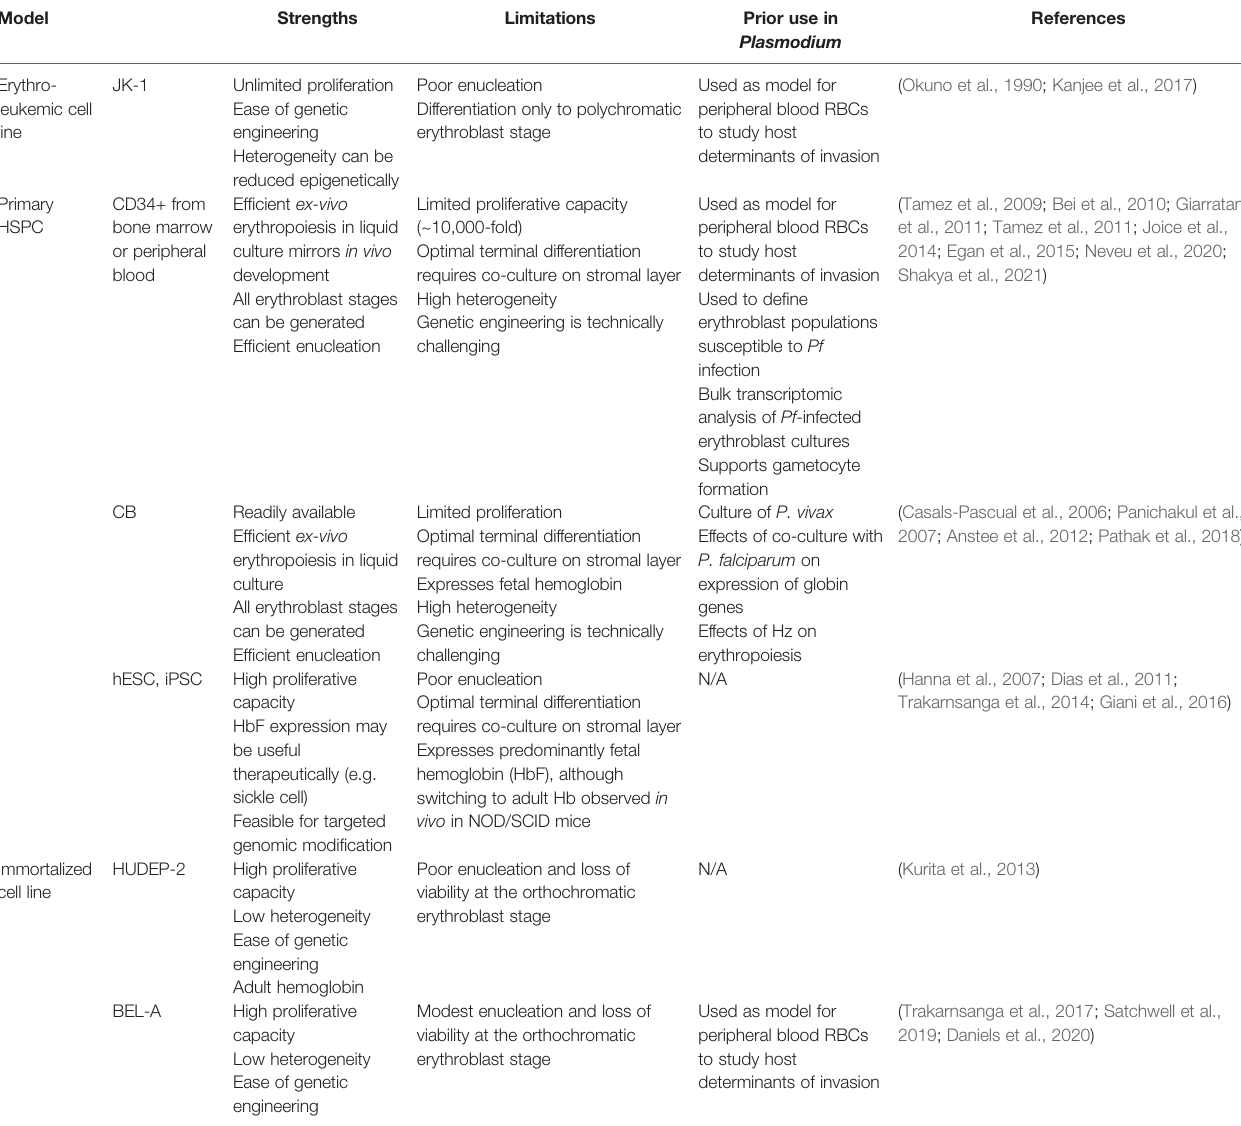
TABLE 1 | Summary of models for ex-vivo erythropoiesis.